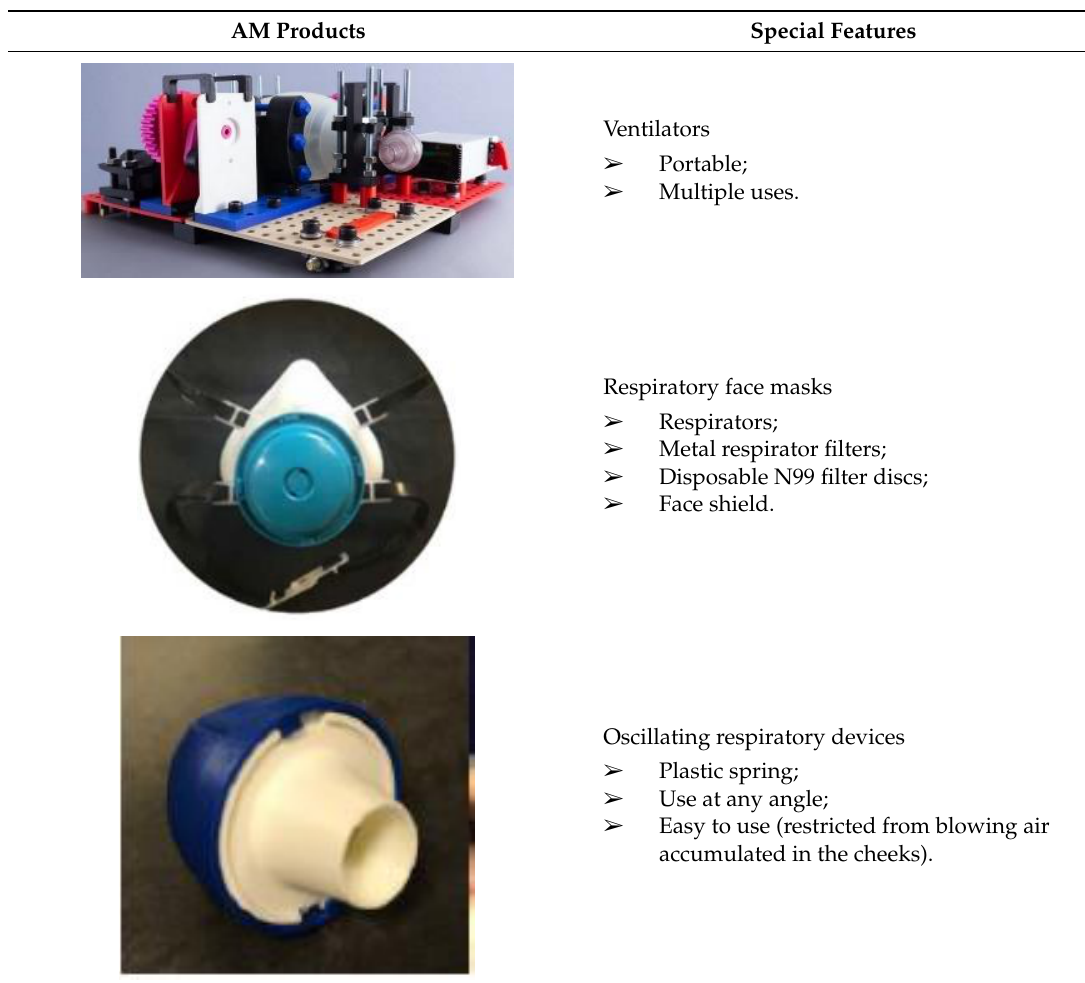
Table 1. AM products provided by the South Africa AM community.